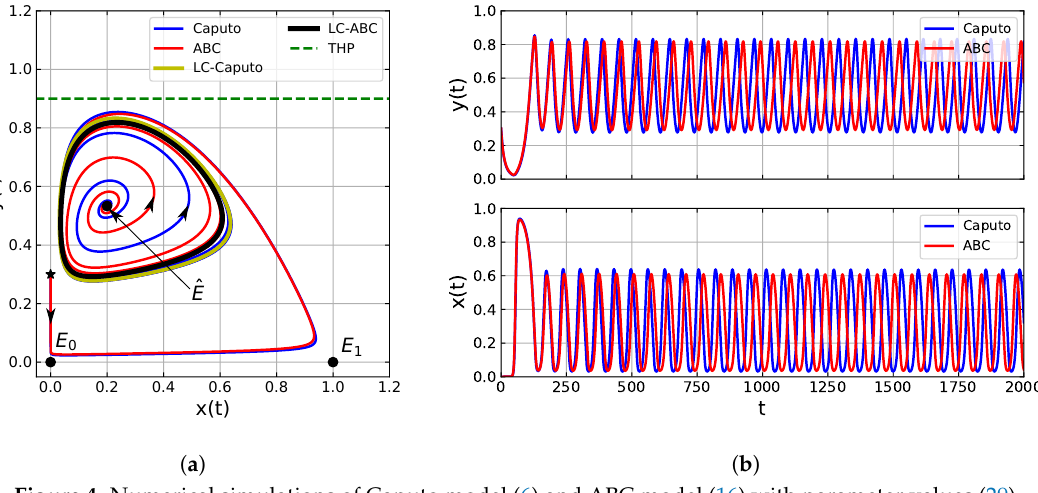
Figure 4. Numerical simulations of Caputo model (6) and ABC model (16) with parameter values (29) and n = 0.2: Figure ( a ) phase portrait; and Figure ( b ) time